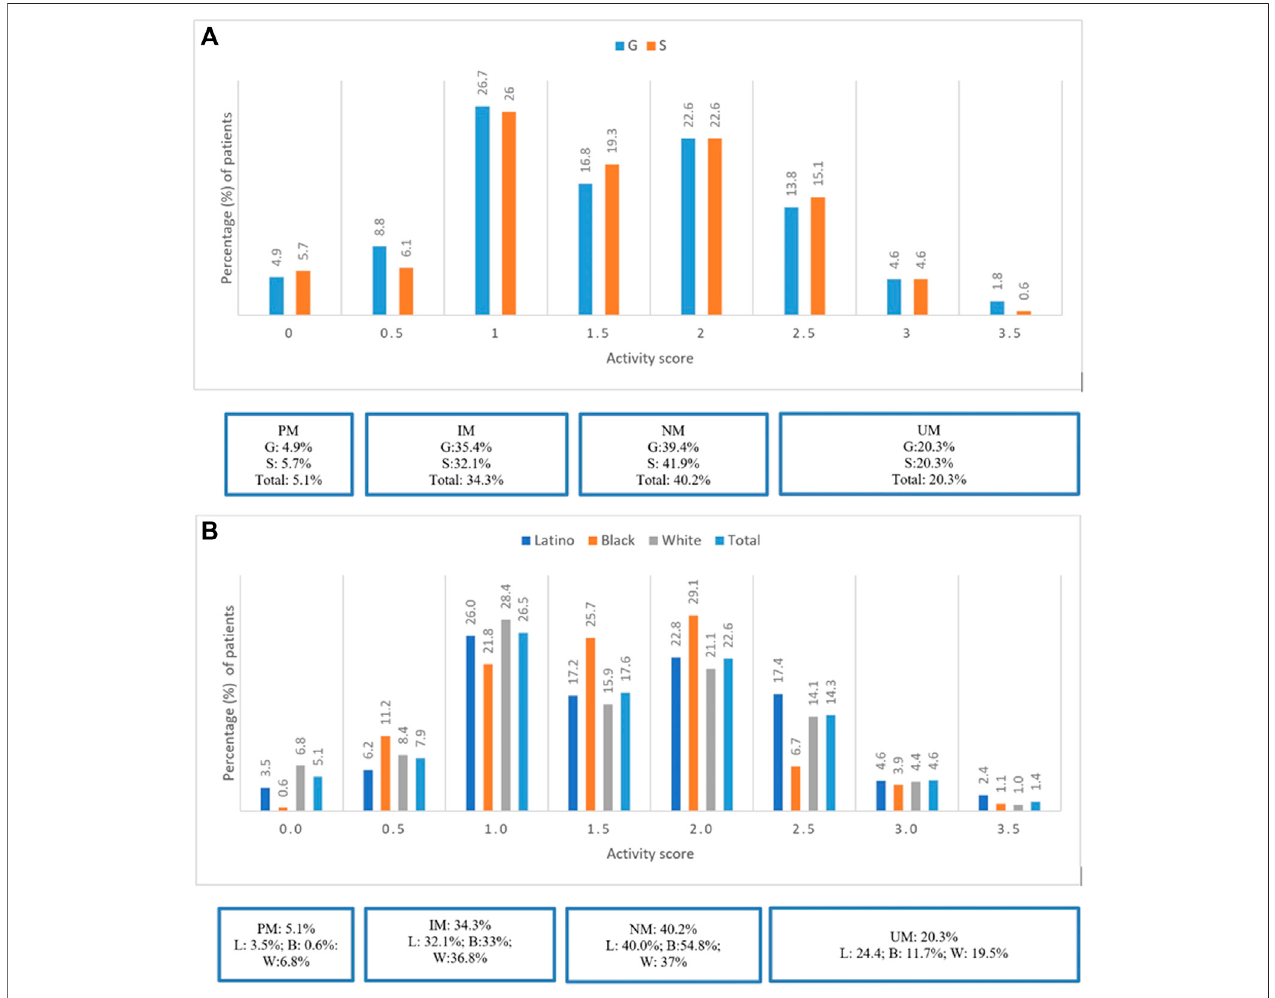
FIGURE 1 | (A) Prevalence of CYP2D6 Phenotypes strati fi ed by groups G and S. (B) Prevalence of CYP2D6 Phenotypes strati fi ed by ethinicity for the total study population.